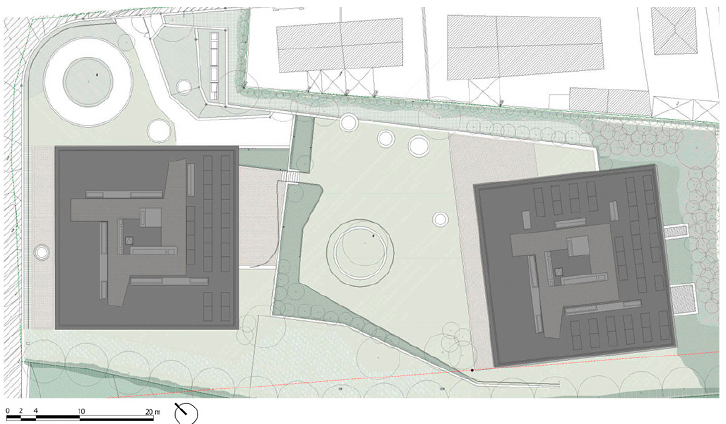
Figure 6. Vila Nova de Gaia. General plan.